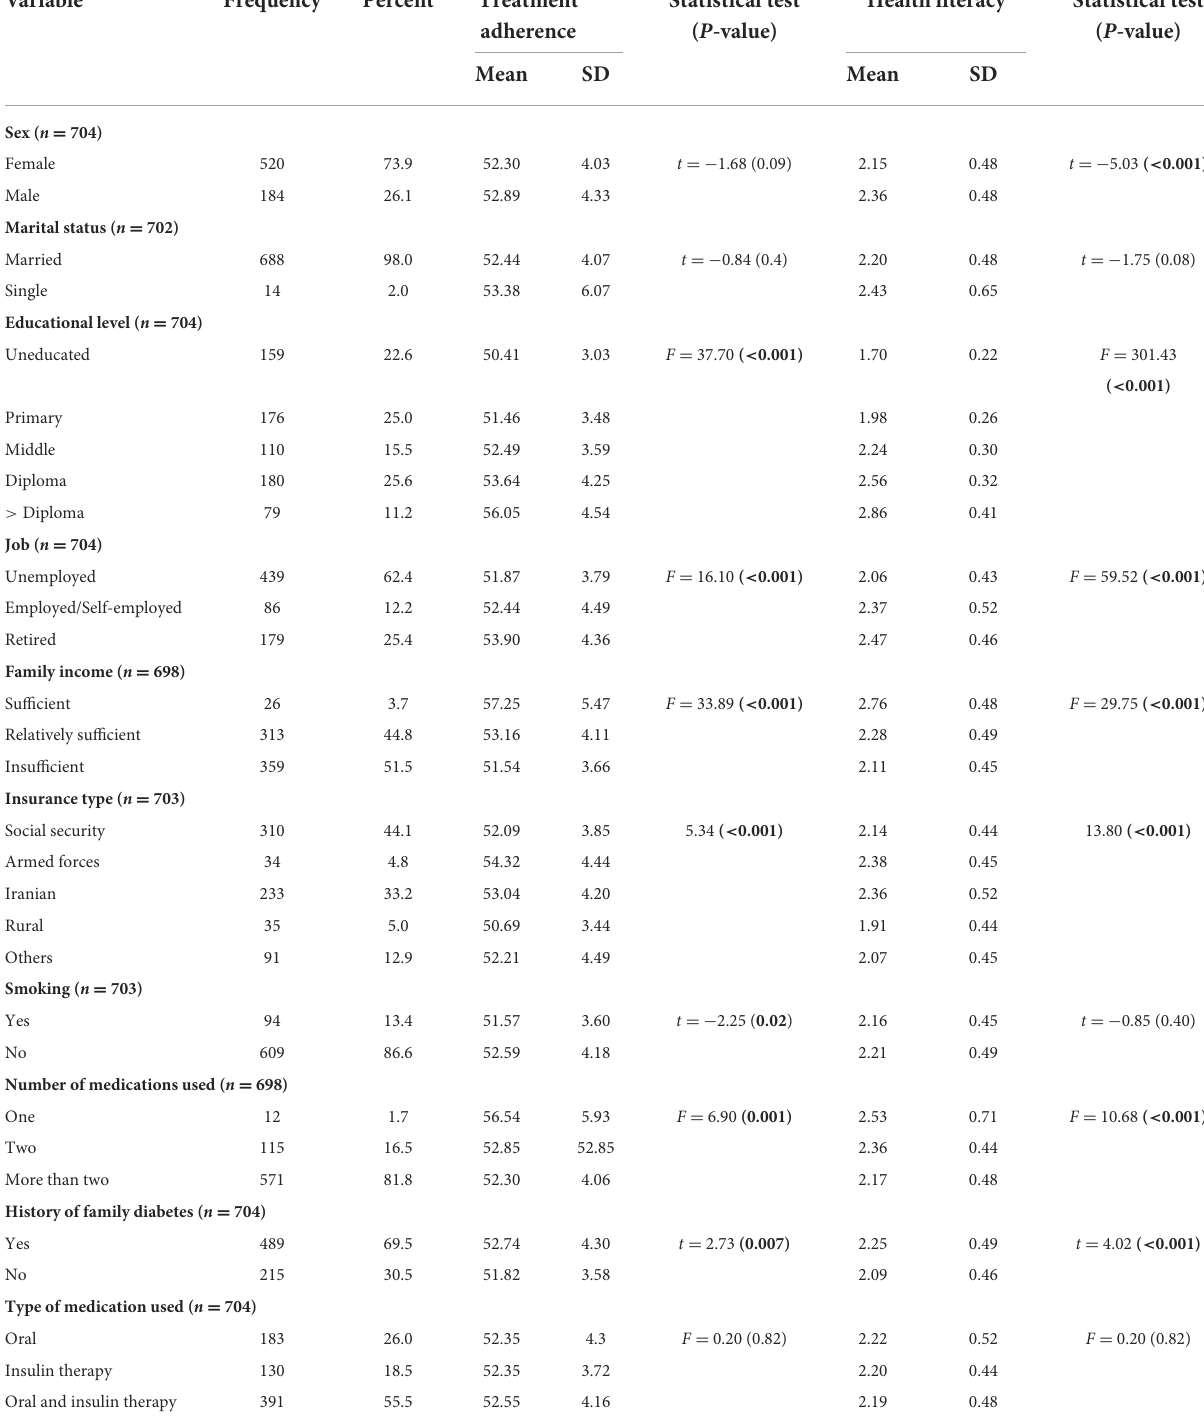
TABLE 2 Mean and standard deviation of demographic and characteristics and their relationships with adherence to treatment and health literacy among study participants.